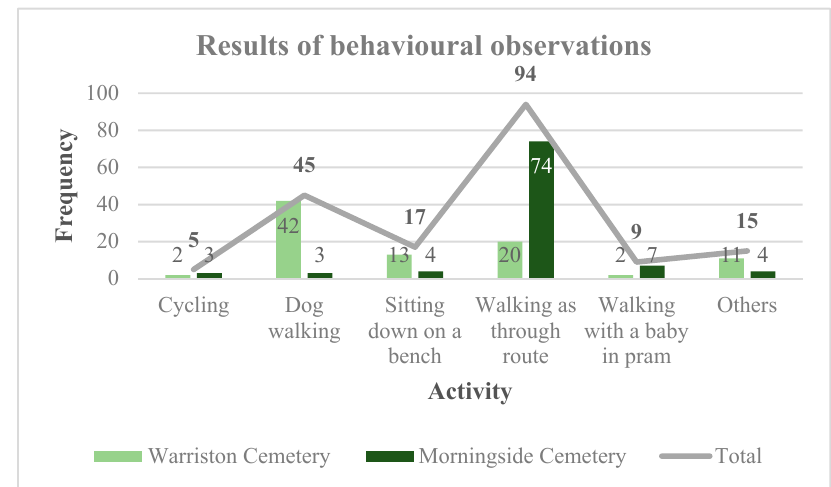
Figure 4. Results of behavioural observations. ‘Others’ include doing voluntary work, meditation, cycling, running, taking photographs, watching birds, and flying drones.